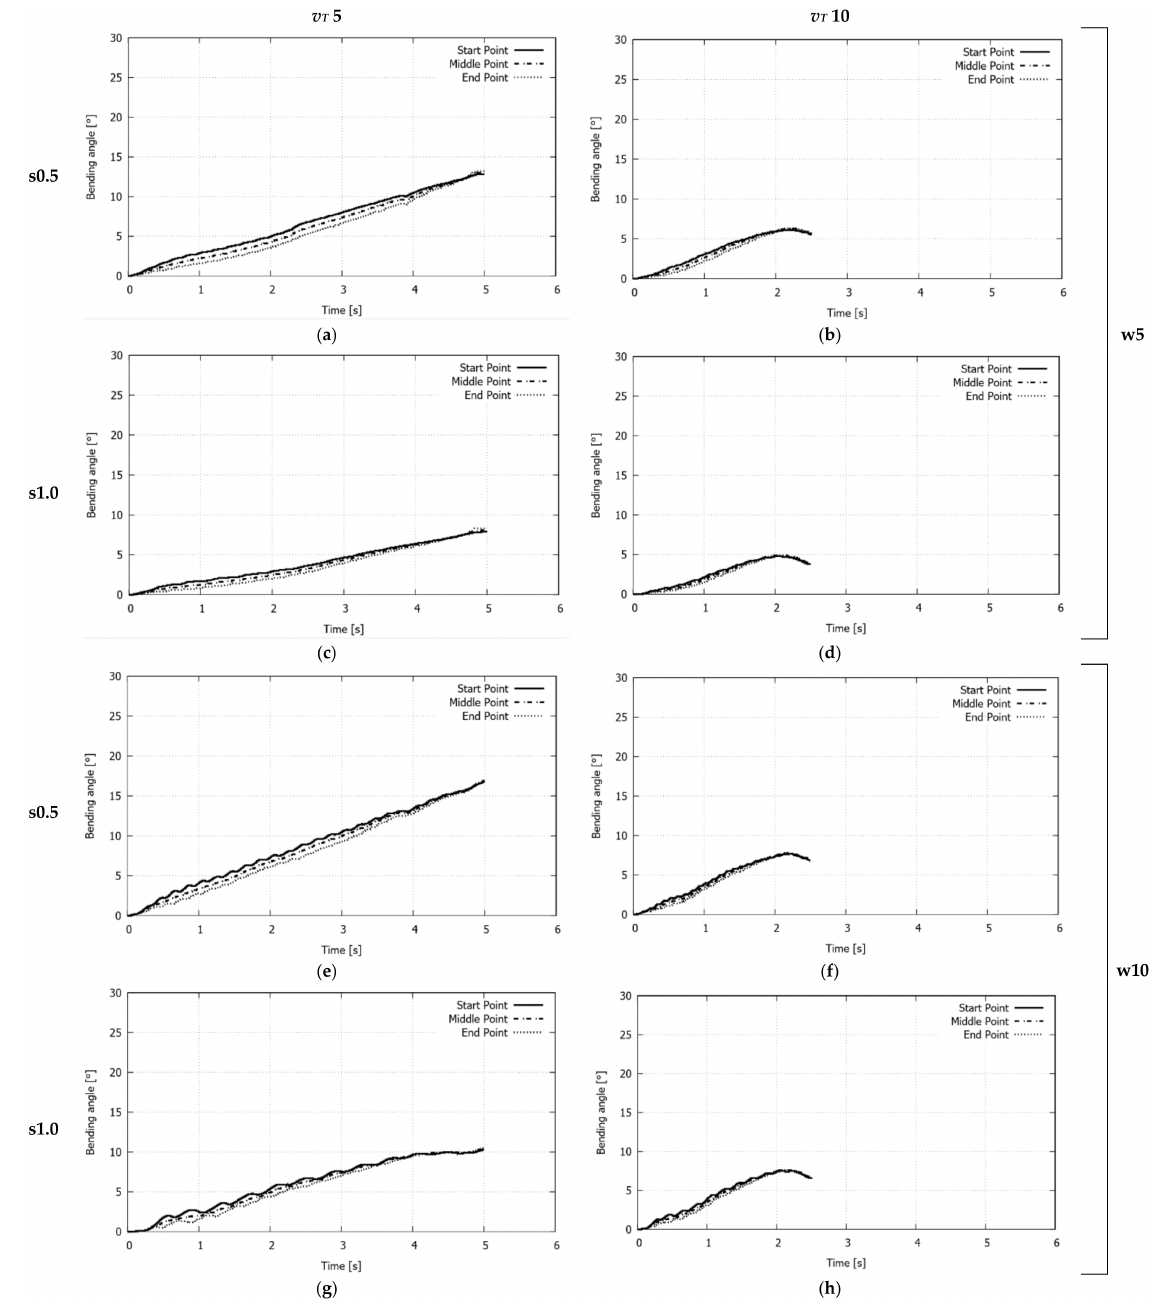
Figure 10. Single S-shape scanning path. Computed bending angle evolution at three points of the free edge of the plate for the studied cases: ( a ) v T = 5 mm/s, s = 0.5 mm, w = 5 mm; ( b ) v T = 10 mm/s, s = 0.5 mm, w = 5 mm; ( c ) v T = 5 mm/s, s = 1.0 mm, w = 5 mm; ( d ) v T = 10 mm/s, s = 1.0 mm, w = 5 mm; ( e ) v T = 5 mm/s, s = 0.5 mm, w = 10 mm; ( f ) v T = 10 mm/s, s = 0.5 mm, w = 10 mm; ( g ) v T = 5 mm/s, s = 1.0 mm, w = 10 mm; ( h ) v T = 10 mm/s, s = 1.0 mm, w = 10